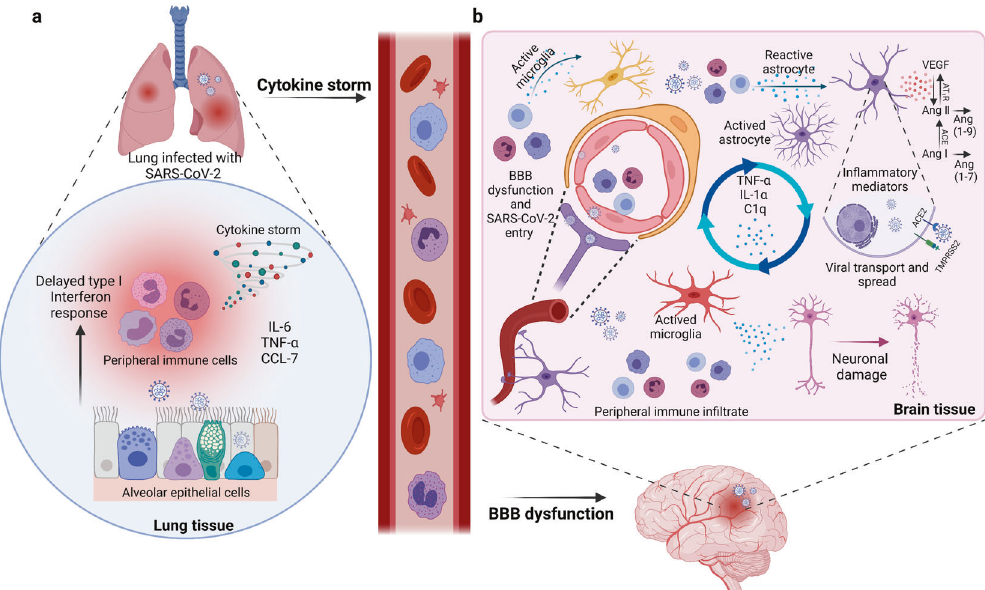
Fig. 4 SARS-CoV-2 infection can cause excessive peripheral immune responses to result in BBB dysfunction. a The cytokine storms with remarkable BBB permeability effects may allow the virus or infected immune cells reach the brain. b Possible CNS pathological mechanisms caused by the severe peripheral hyperin fl ammation associated with COVID-19. The infected immune cells invade in brain and release cytokines to activate glial cells to release pro-in fl ammatory cytokines and VEGF which could cause severe neurological symptoms in